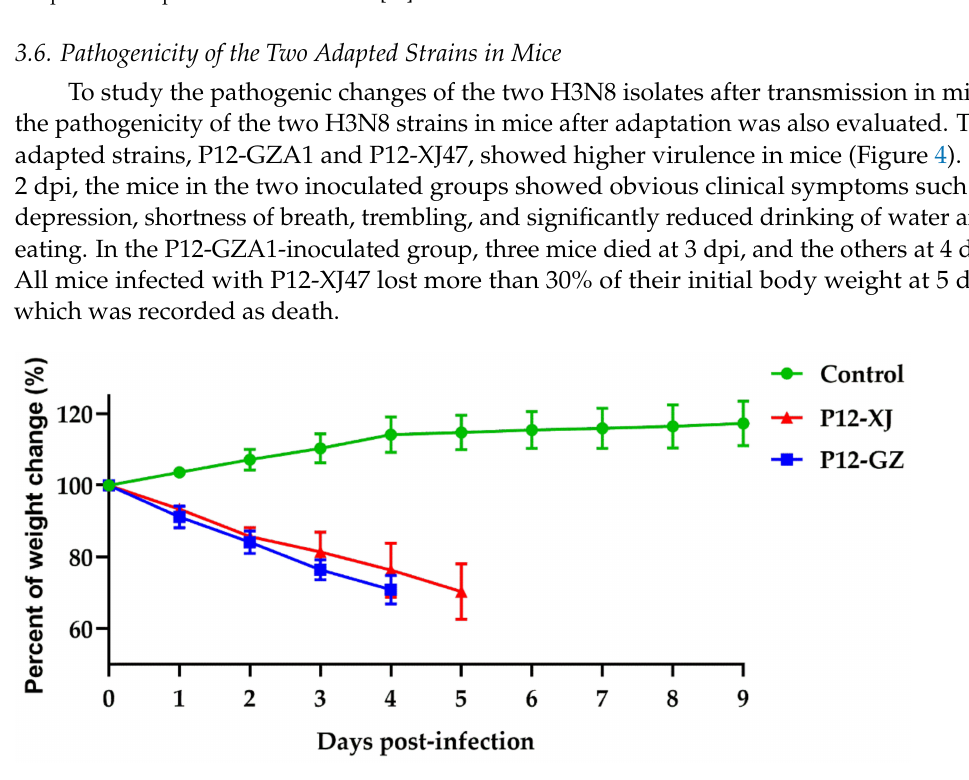
Figure 4. Daily weight changes of mice were recorded within 14 days after infection with the P12- GZA1- and P12-XJ47-adapted strains. Values represent the mean percentage ± SD relative to the original body weight of the